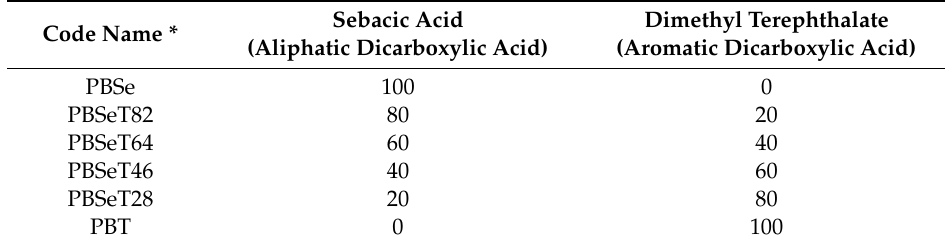
Table 1. Abbreviations of the studied samples with various molar ratios of aliphatic / aromatic dicarboxylic acid group.